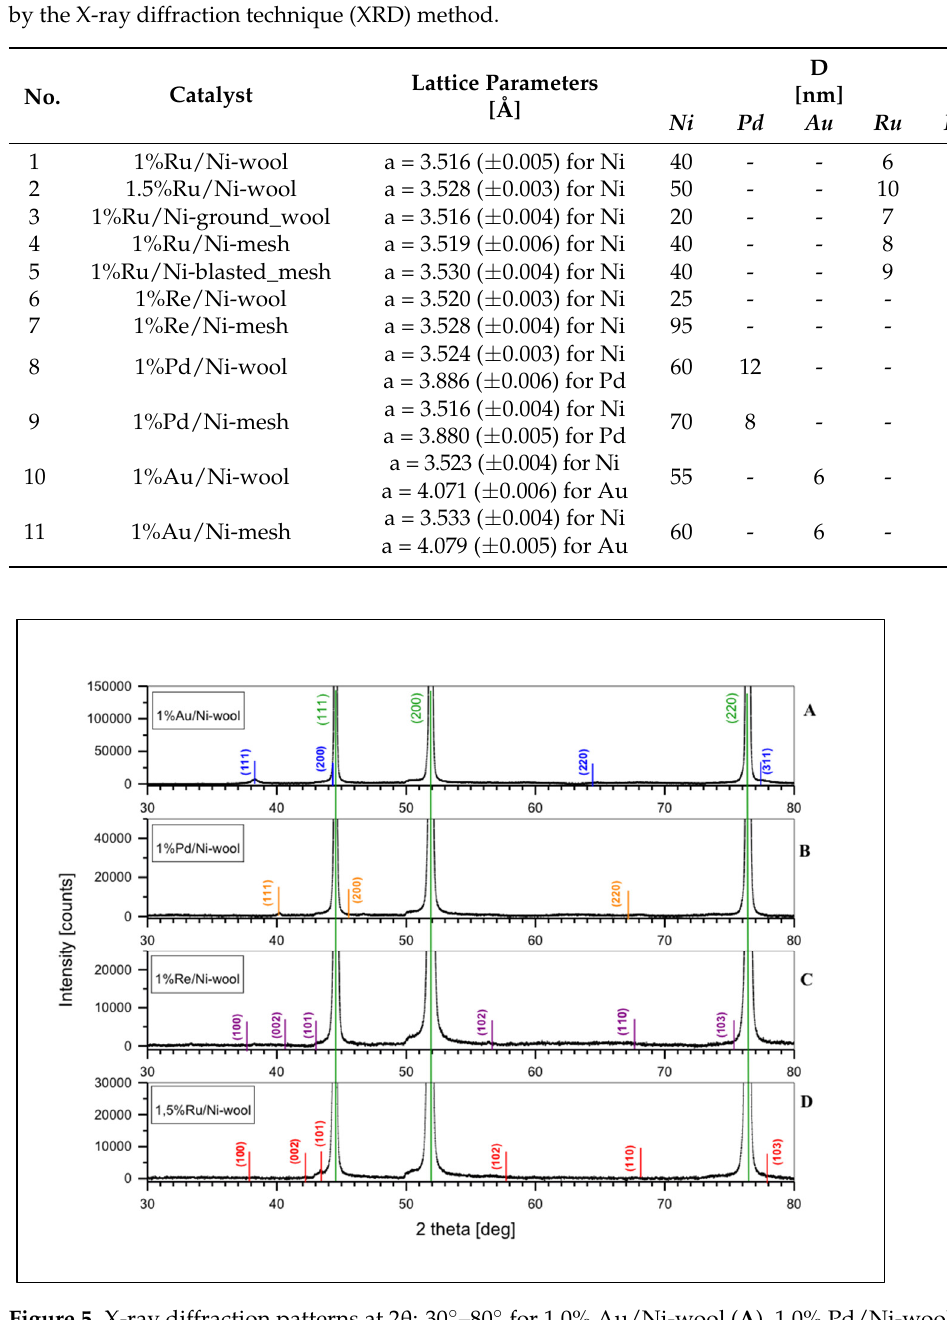
Figure 5. X-ray diffraction patterns at 2θ: 30°–80° for 1.0% Au/Ni-wool ( A ), 1.0% Pd/Ni-wool ( B ), 1.0% Re/Ni-wool ( C ), 1.5% Ru/Ni-wool ( D ) samples. Miller indices for experimental peaks of Ni (green) wool fibers and Au (blue), Pd (orange), Re (purple), Ru (red) metals are marked. The X-ray diffraction patterns of the 1%Au/Ni-wool, 1%Pd/Ni-wool, 1%Re/Ni-wool, and 1.5%Ru/Ni-wool are given in the range of the 2θ angle from 30 to 80 degrees. They clearly show the diffraction lines that correspond to the face-centered cubic (Fm3m) phase of Ni (JCPDS 01-077-8341), whereas only the most intense peaks of the cubic (Fm3m) phases of Au (2θ 111 ~38°) and Pd (2θ 111 ~40°) are identified. The overlapping diffraction lines were observed. The strongest diffraction lines of the hexagonal (P63/mmc) phases of Ru and Re (2θ 101 ~43°−44°) overlap Ni (111) diffraction line, whereas the less intensive peaks of Ru and Re were not detected. The qualitative and quantitative elemental analysis